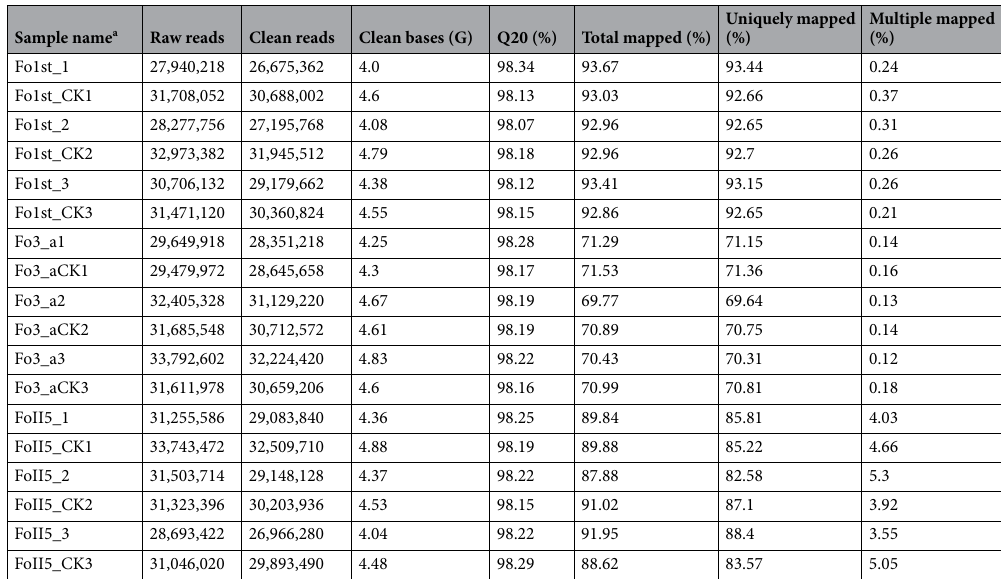
Table 2. Mapping results of RNA-Seq data from phenamacril-sensitive and -resistant Fo isolates under 1 μg/ mL phenamacril treatment and 0.1 μL/mL methanol treatment condtions. a Letter ‘CK’ represents the control groups treated with 0.1 μL/mL methanol and others represent the treatment groups treated with 1 μg/mL phenamacril. The number after the letters represent three biological